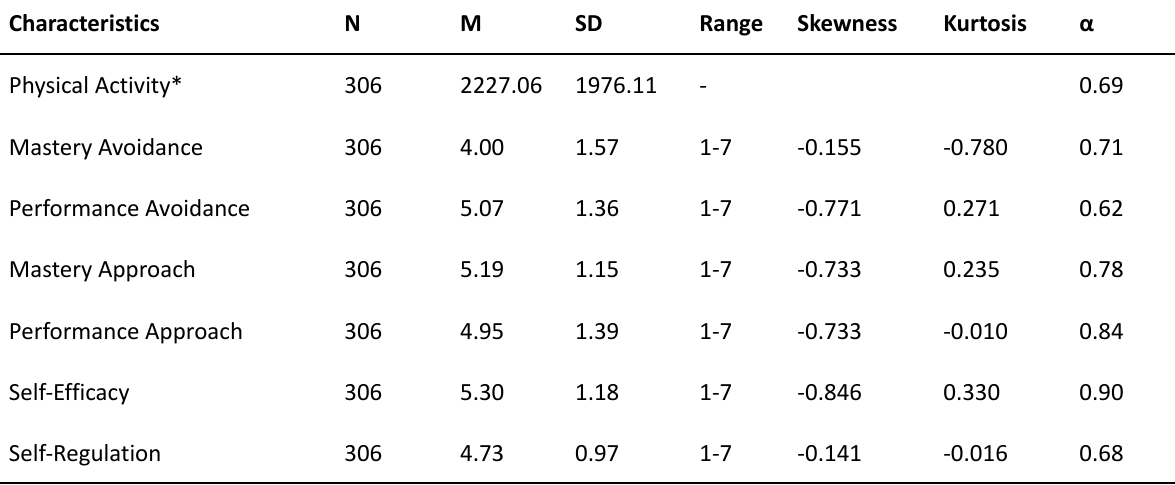
Table 2. Descriptive characteristics of participants